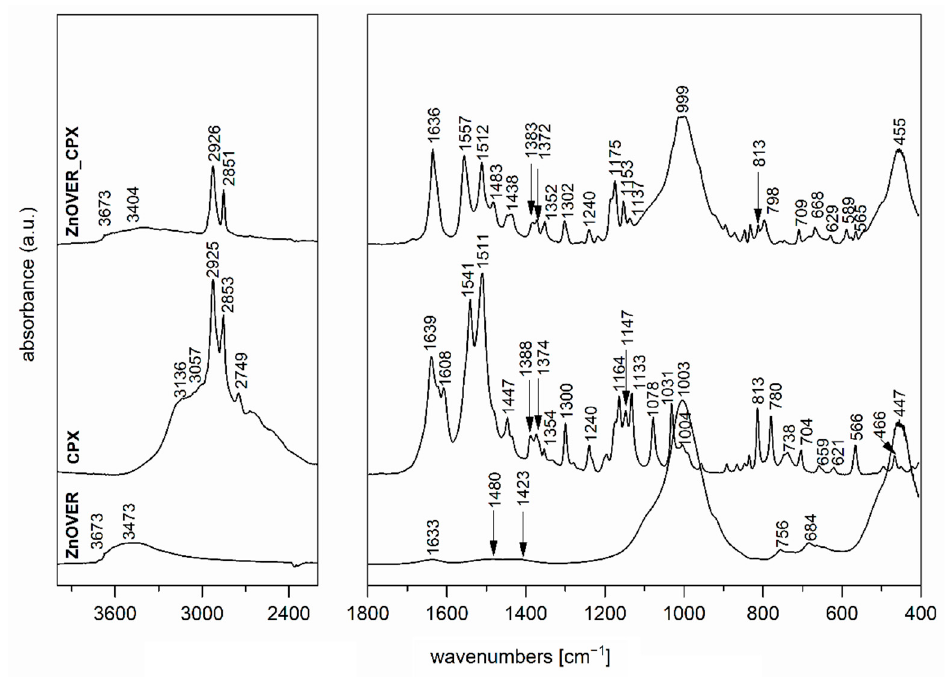
Figure 4. FTIR spectra of ZnOVER nanofiller, CPX, and ZnOVER_CPX nanofiller.